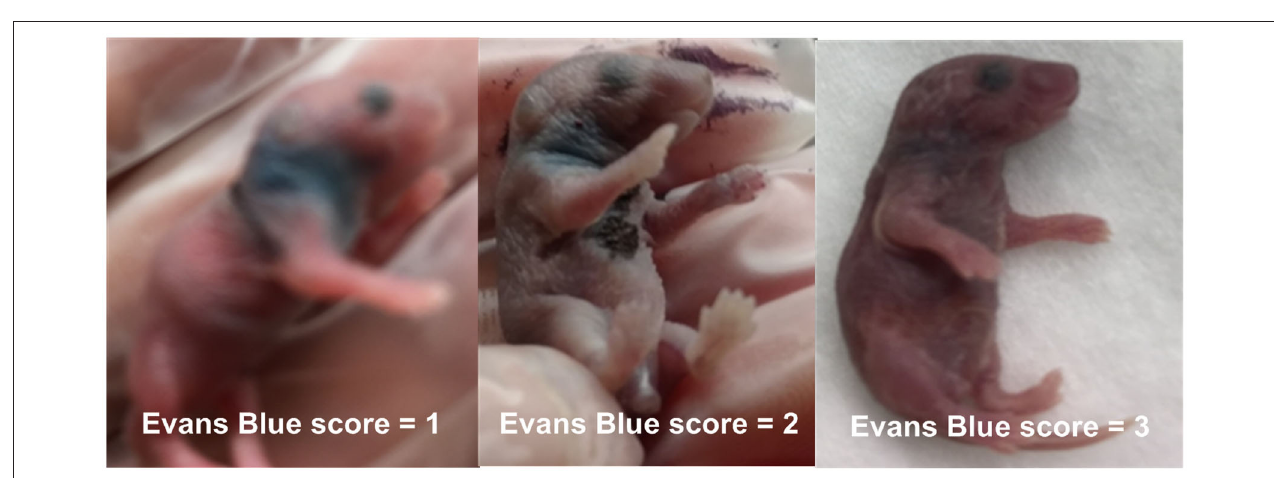
FIGURE 2 | Evans blue IV injection quality score. 0.05% Evans blue dye was added to the bacterial inoculum prior to injection, and images were taken immediately after IV injection. Successful IV bacterial injections led to homogenous discoloration of neonatal mice (score = 3), partial extravasation led to local discoloration at the injection site with slight general discoloration (score = 2), and failed IV injections appeared as localized blue discoloration without general color changes (score = 1), as demonstrated on these representative photographs.